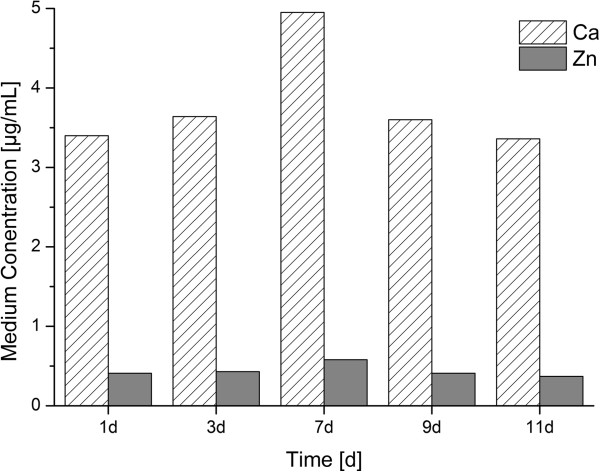
Changes with time of zinc and calcium concentration in MH medium. The concentrations of zinc and calcium in the medium did not show fluctuation and the mean concentrations showed only small standard deviations for calcium 3.98 ± 0.6 μg/mL and for zinc 0.44 ± 0.08 μg/mL.